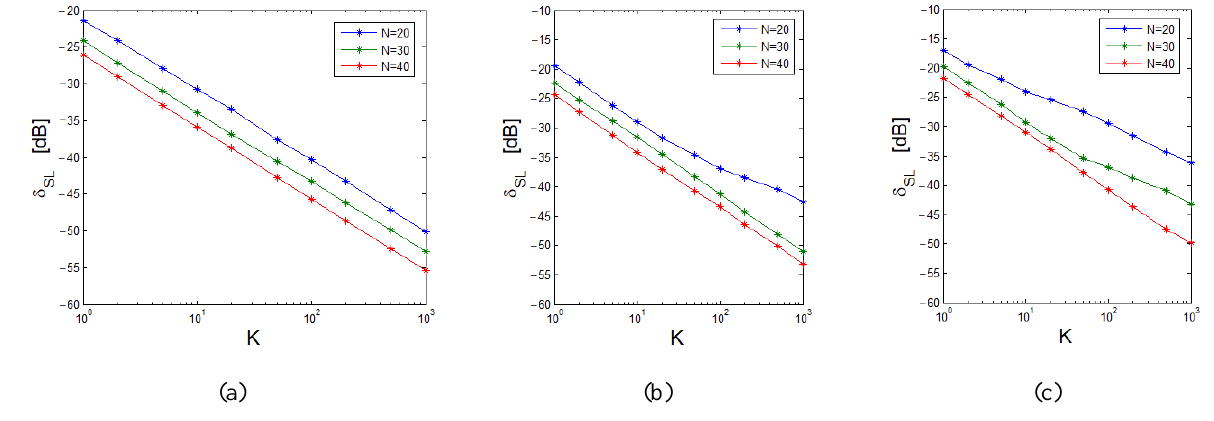
Figure 4. Maximum side lobe level δ SL (in dB) as a function of K . The curves are obtained for u MB = 0.5 and ( a ) ∆ u = 0.2, ( b ) ∆ u = 0.15, and ( c ) ∆ u = 0.1 .